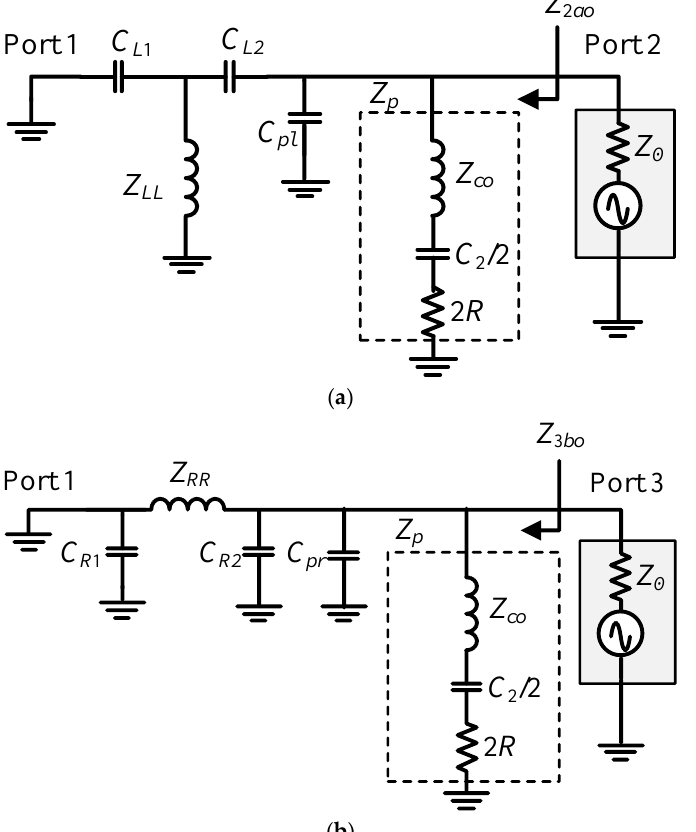
and ( b ) Port 1 and Port 3.